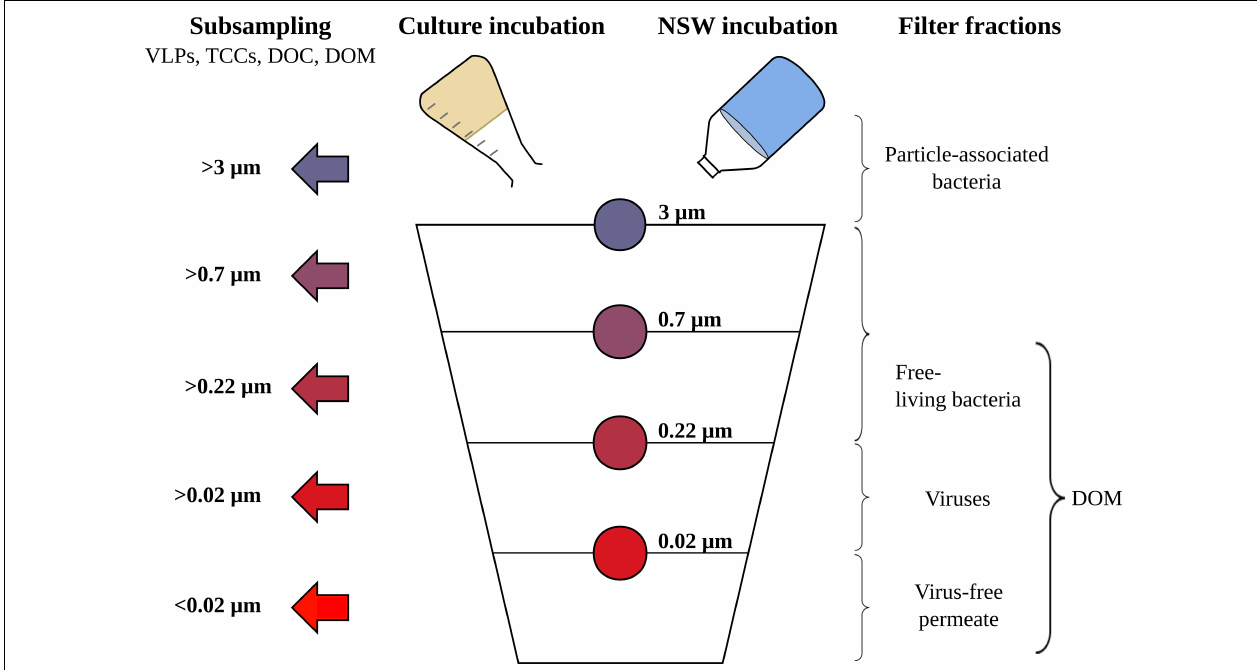
FIGURE 1 | Schematic overview of the sequential filtration steps for the Rhodovulum sulfidophilum cultures and North Sea water (NSW) setups, including all size filter fractions (indicated by the color code) and subsampling steps (indicated by the arrows). Subsampling was done for counting of virus-like particles (VLPs) and bacterial cells (TCCs), dissolved organic carbon (DOC) quantification and the molecular characterization of dissolved organic matter (DOM).